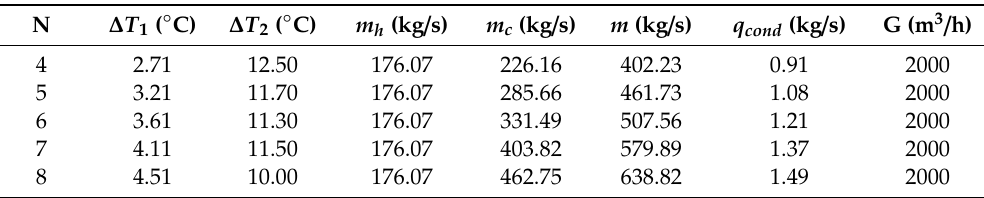
Table 2. Operation parameters with di ff erent N values.